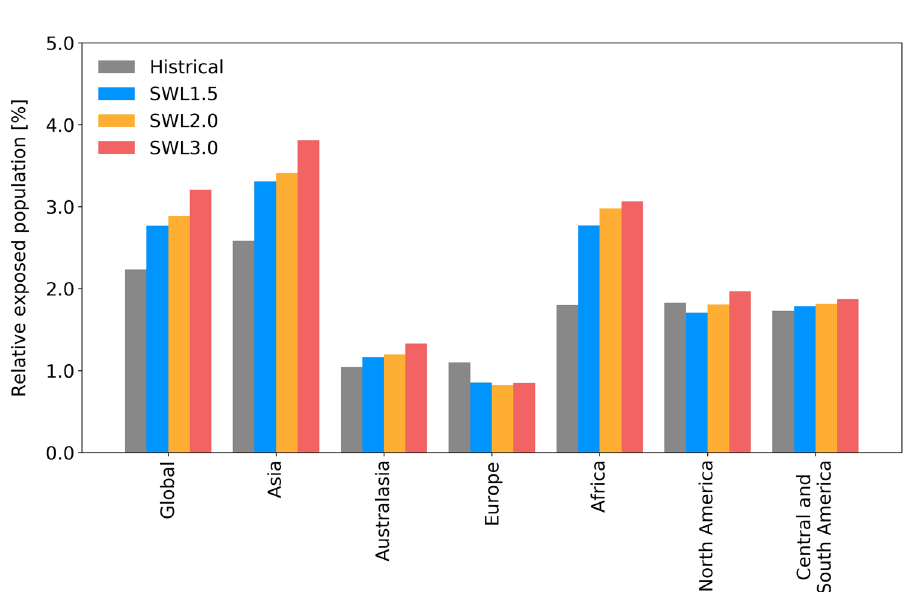
Figure 3. Potential flood exposure during the baseline period and projected future warming levels. The ssp585 scenario (SSP5 and RCP8.5) was applied to different regions. The percentage of the regional total population (fixed at the 2015 level) is shown for each